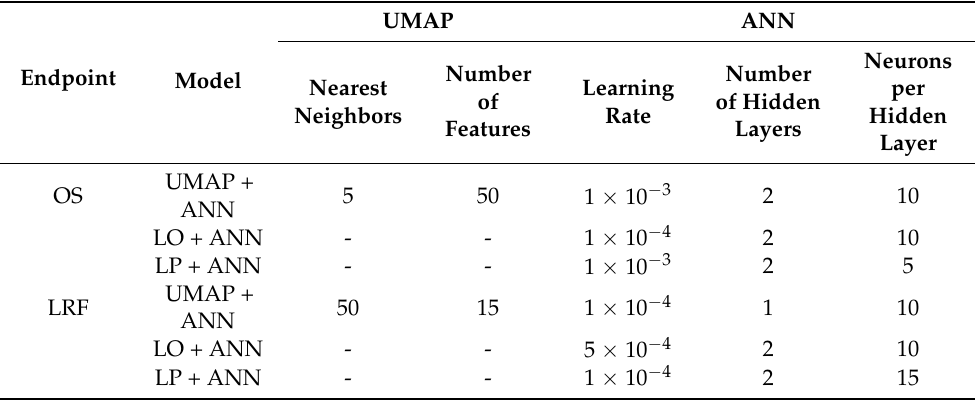
Table 2. Sets of best hyper-parameters found for the different models by performing 3-fold cross validation with several different hyper-parameter